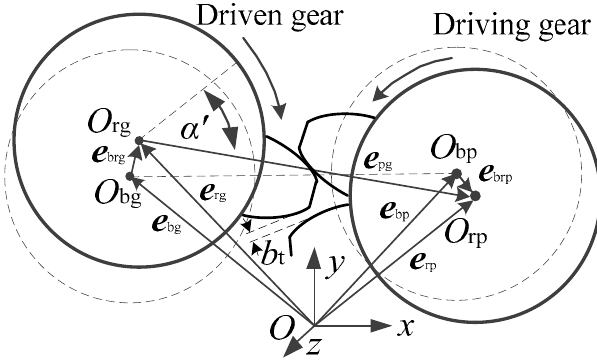
Figure 2. Multi-clearance coupling model.